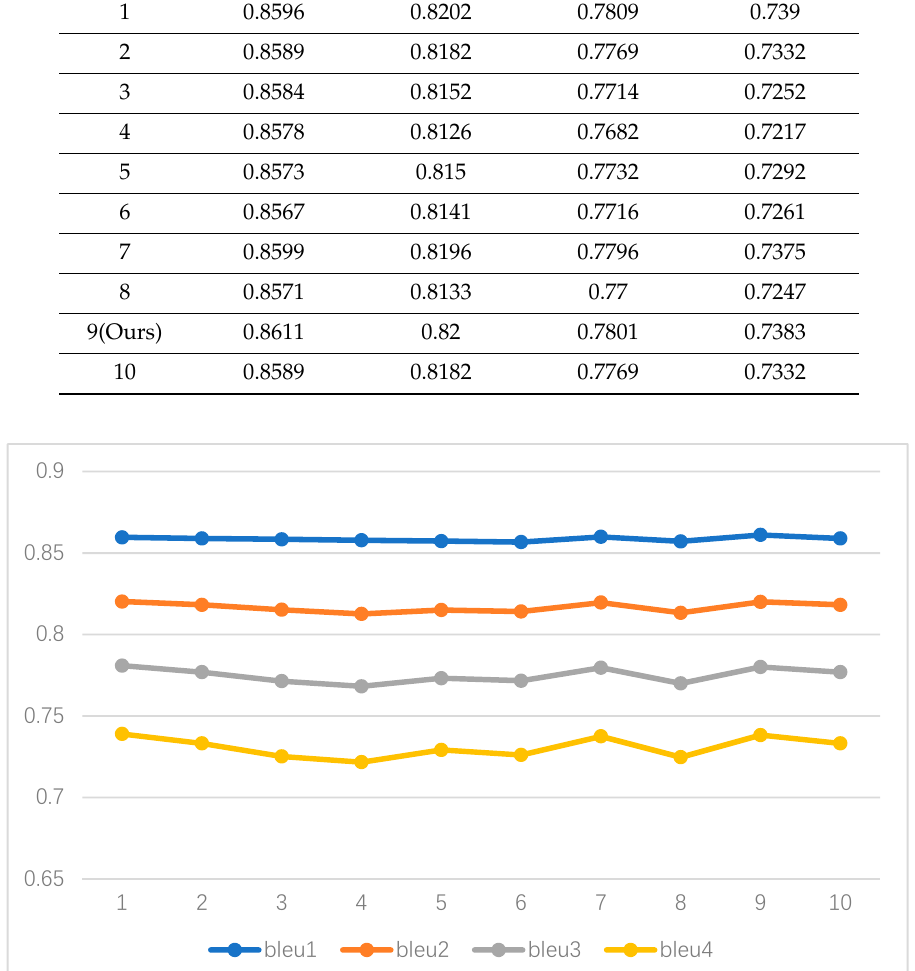
Figure 14. Bleu trend of the 10 experiments. It can be seen from the figure that in these experiments, the variation amplitudes of Bleu_1, Bleu_2, Bleu_3 and Bleu_4 are subtle, which can prove the randomness of the data distribution and the robustness of the experiments.